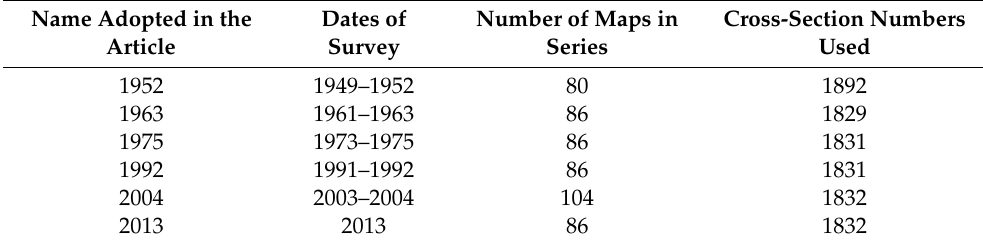
Table 1. Summary of di ff erent hydrographic surveys used in this